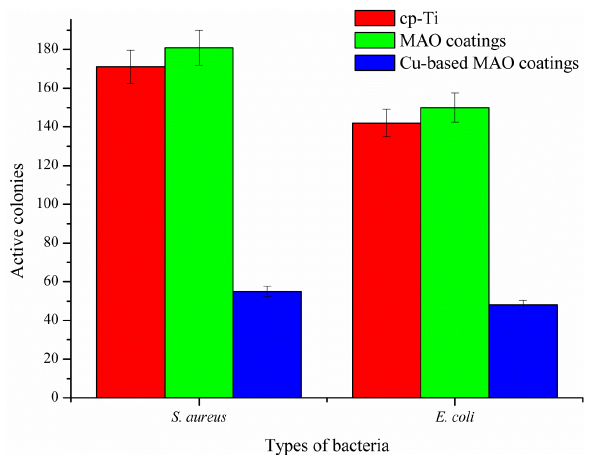
Figure 7. Active colony ratios of S. aureus as gram positive bacteria and E. coli as gram negative bacteria on cp-Ti substrate, the MAO and Cu-based MAO surface cultivation.